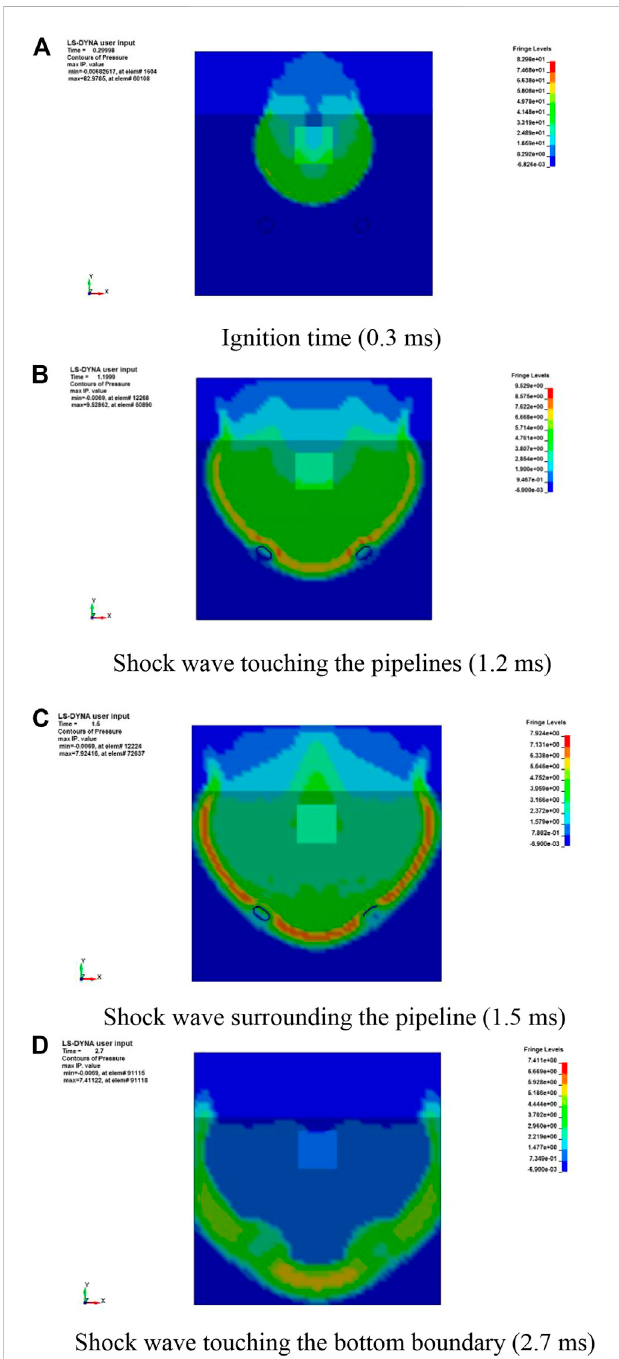
FIGURE 12 Main propagation processes of the shock wave. (A) Ignition time (.3 ms). (B – D) Shock waves touching the pipelines (1.2 ms), surrounding the pipeline (1.5 ms), and touching the bottom boundary (2.7 ms),